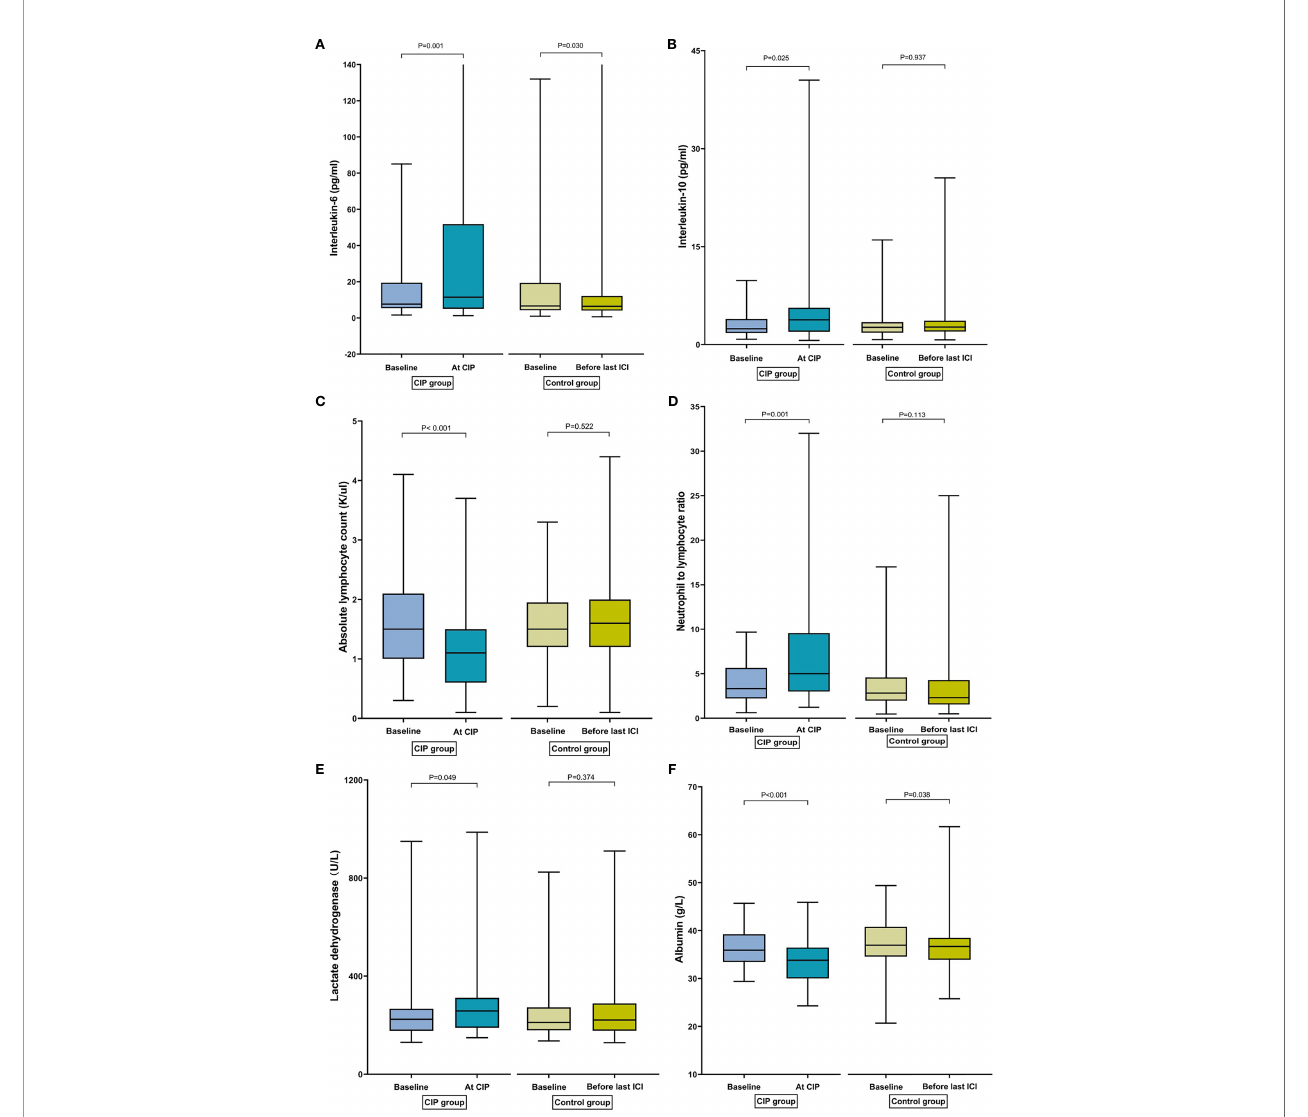
FIGURE 2 | Bar plots of peripheral blood parameters in patients with checkpoint inhibitor-related pneumonitis (CIP) and controls at different time points. (A) Interleukin-6. (B) Interleukin-10. (C) Absolute lymphocyte count. (D) Neutrophil-to-lymphocyte ratio. (E) Lactate dehydrogenase. (F) Albumin.